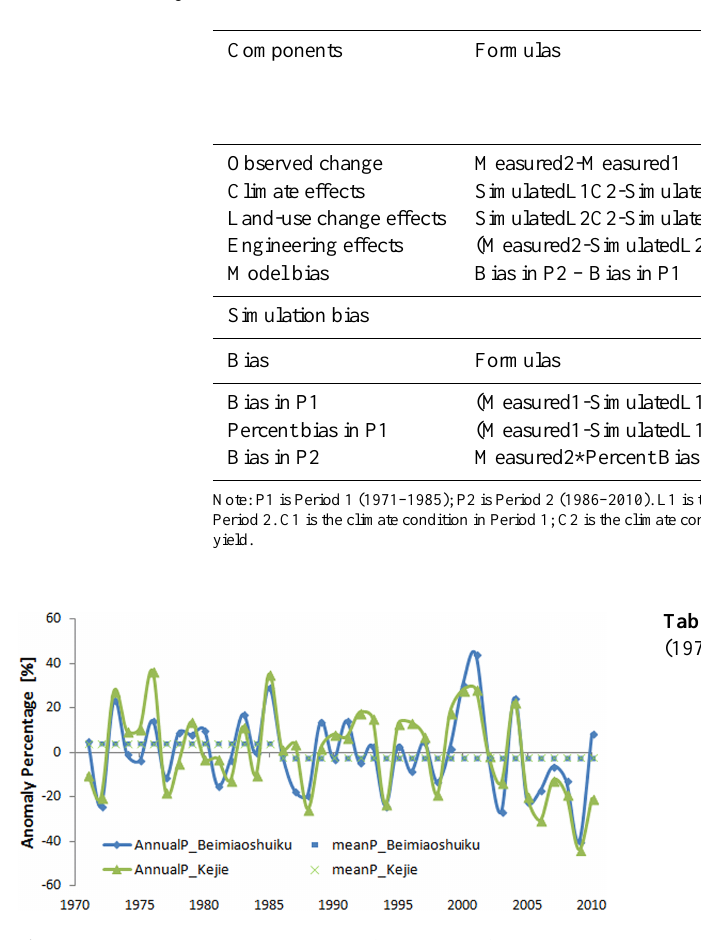
Table 6. Contribution of vegetation restoration, climate change and other engineering measures to suspended sediment between Period 1 and Period 2 in the Kejie watershed.